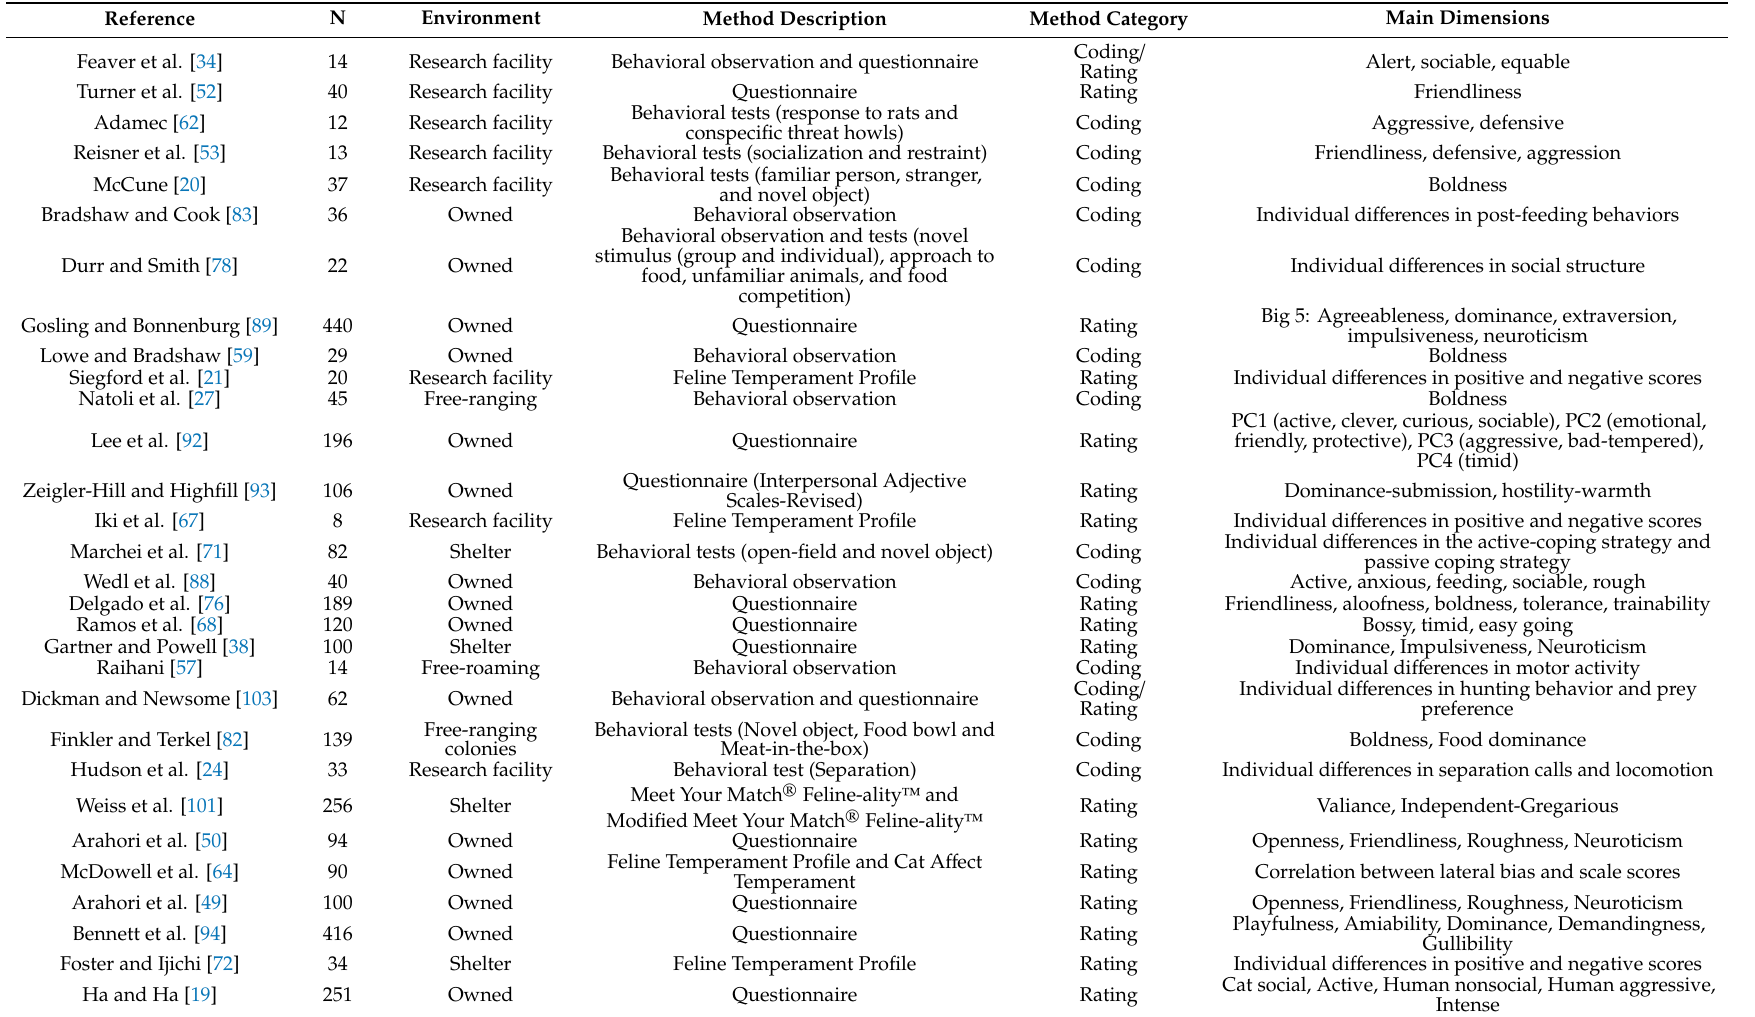
Table 1. Summary of the 43 articles about temperament / personality in domestic cats included in this review. N = sample size and PC = principal